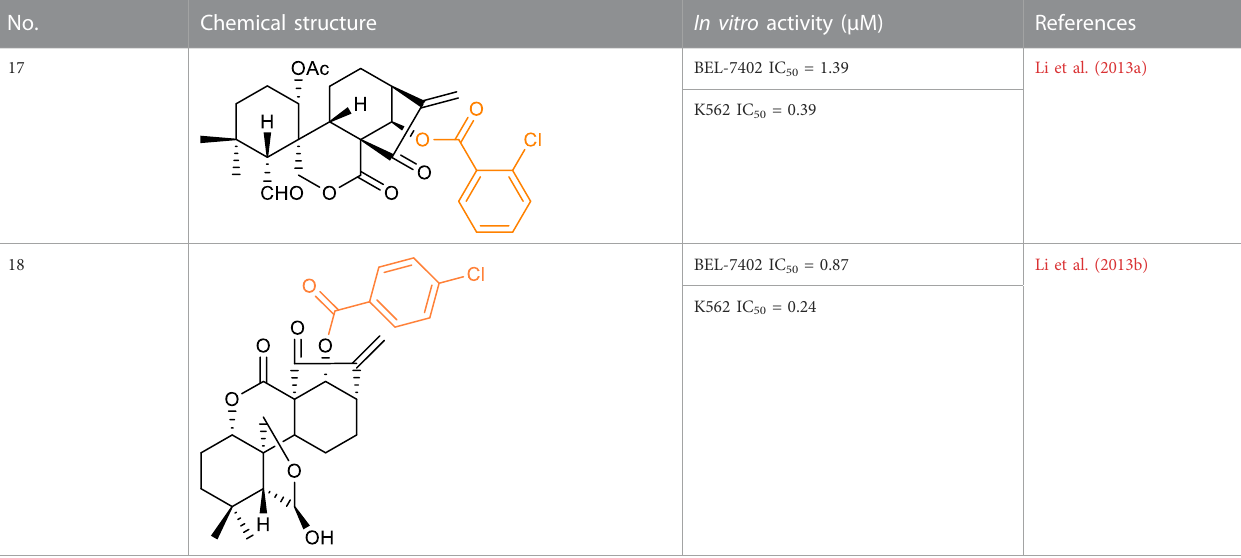
TABLE 4 Recent approaches of oridonin optimizations (transformations of the skeletal structure).